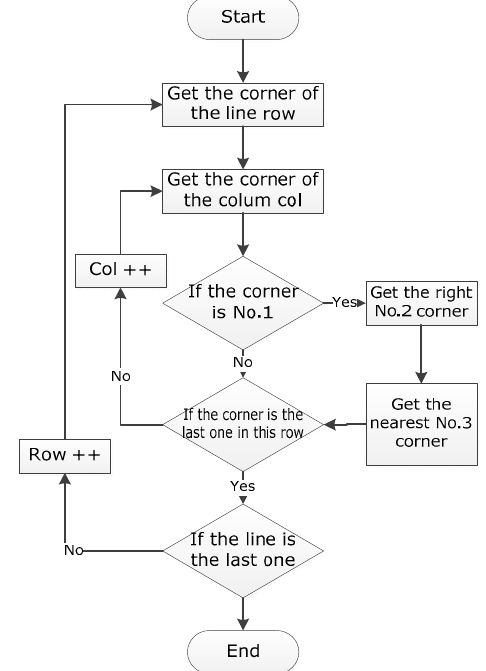
Figure 7. Segmentation process of the borehole log.